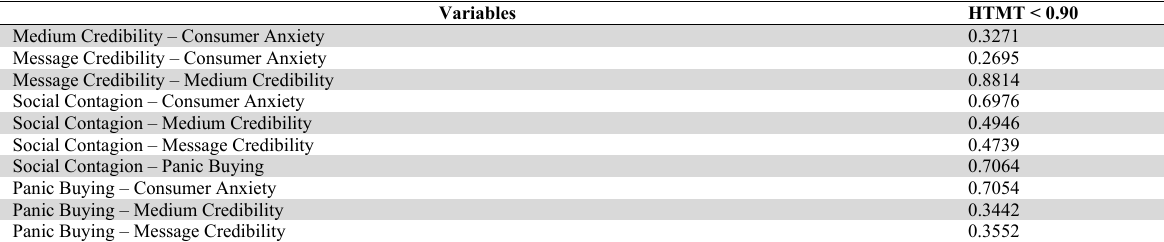
Discriminant Test Results with HTMT. 90